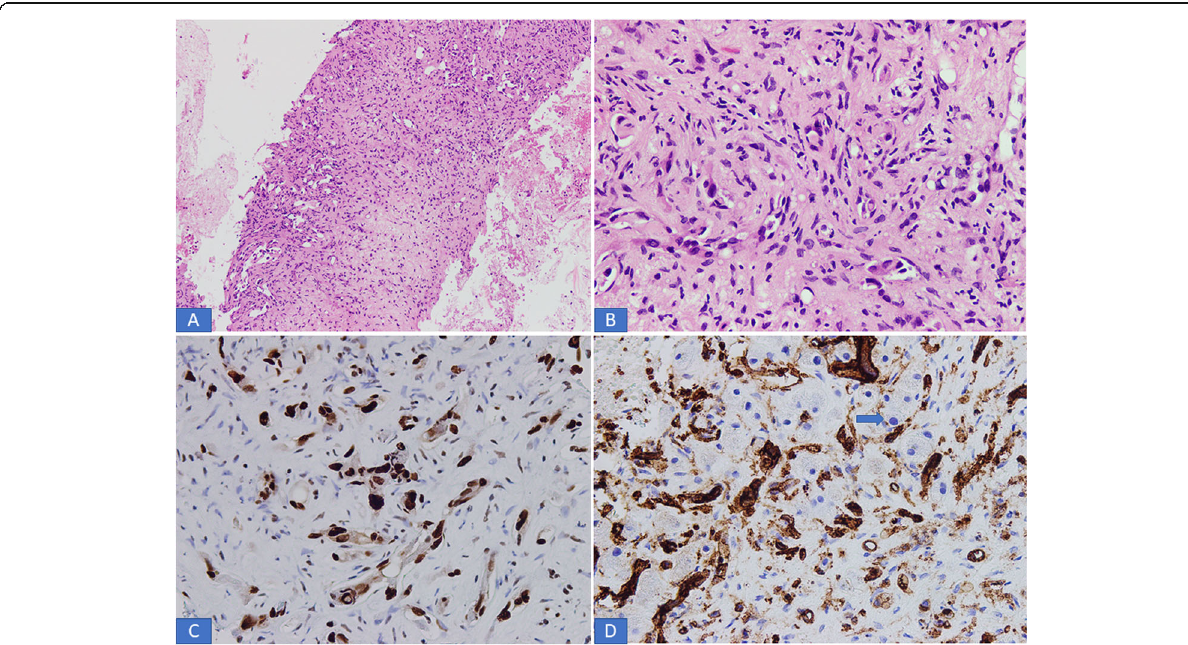
Fig. 3 a-b . Low and high-power examination of hepatic EHE. Cords of epithelioid cells having cytoplasmic vacuoles and hyperchromatic nuclei. c Nuclear positivity for ERG. d CD31 positivity in tumor. The residual hepatocytes are negative for CD31